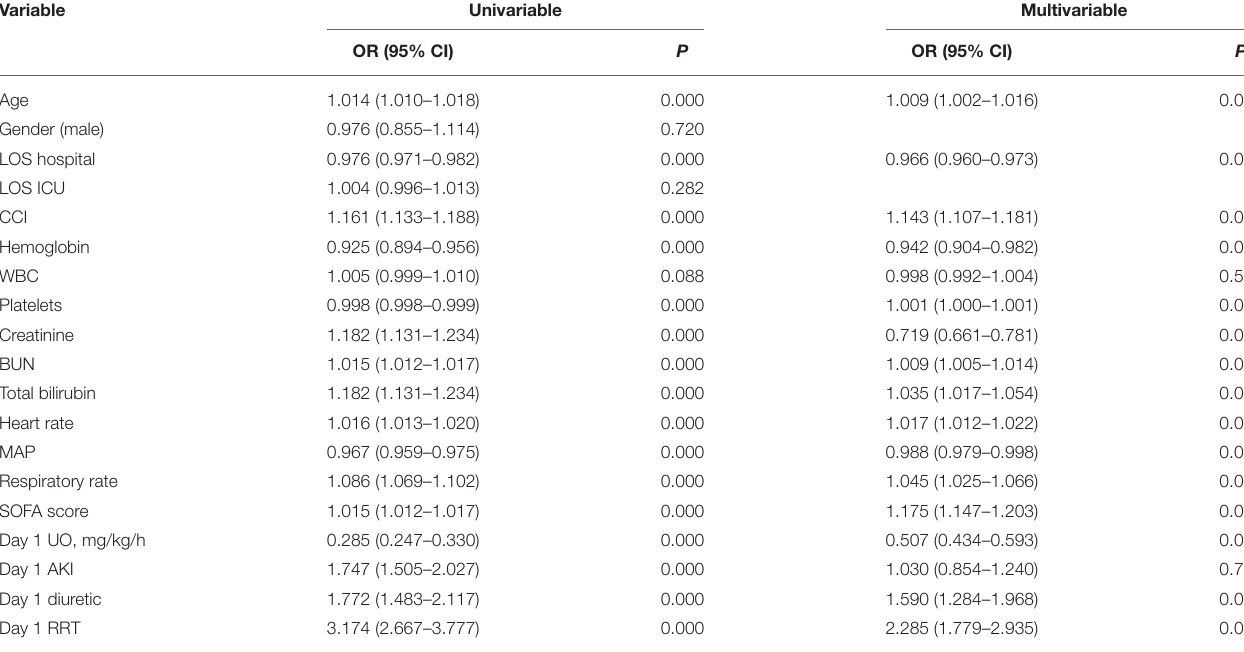
TABLE 2 | Binomial Logistic regression analysis of urine output for in-hospital mortality among intensive care patients with septic shock (before PSM).